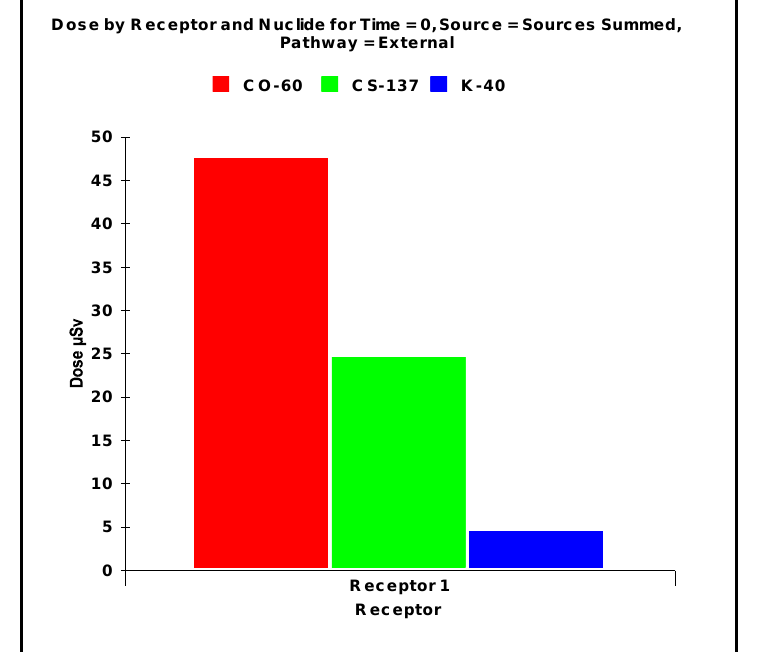
Fig.6: The doses from three sources in germanium system